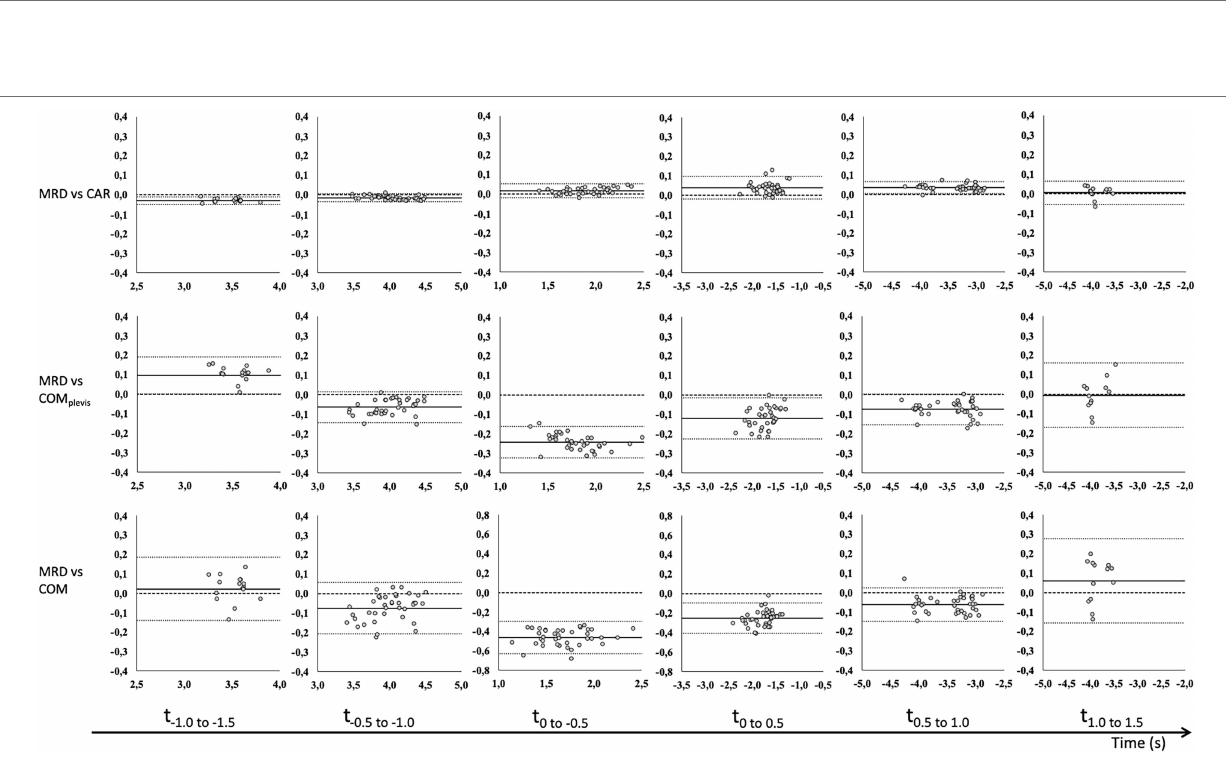
FIGURE 3 | Bland–Altman analysis of average velocity for 0.5 s time intervals before ( − ) and after (+) CoD (horizontal axis) for the MRD to CAR (top row), COM pelvis (middle row) and COM (bottom row) for 6 kg external load. Bland–Altman plots [y-axis: difference in velocity (m/s) and x-axis: average velocity (m/s)] for all trials with fixed bias (full line) with 95% confidence interval (dotted line) and agreement (dashed